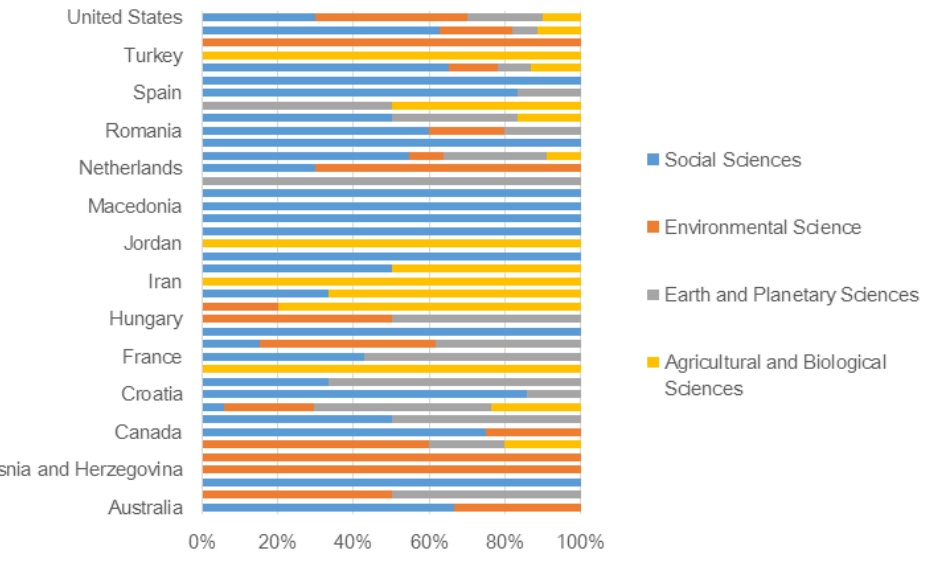
Figure 11. Distribution of journals by area and country of publication in Scopus. Source: Authors’ own data.